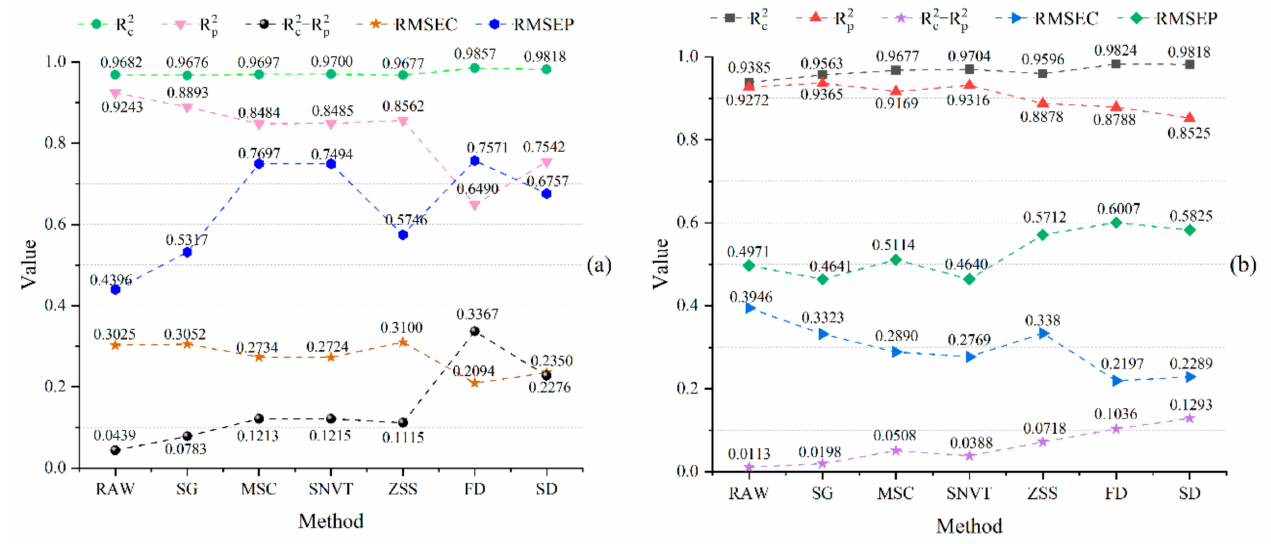
Figure 2. Prediction results of GBR model with different inputs. ( a ) Modeling results based on KS partition data set; ( b ) Modeling results based on SPXY partition data